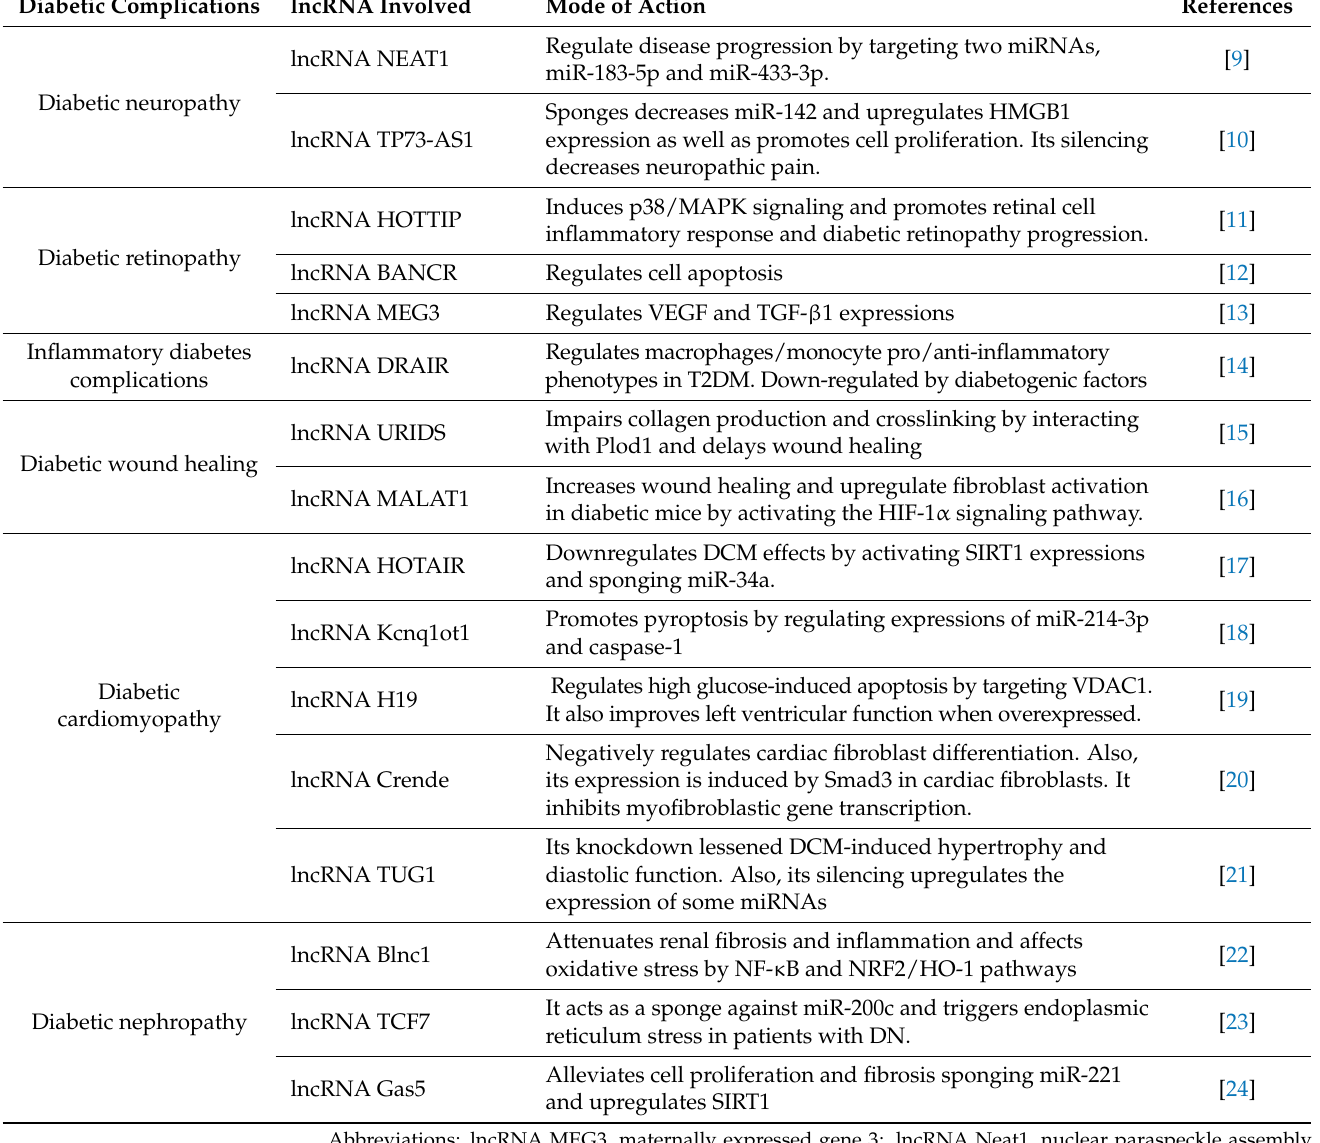
Table 1. LncRNAs involved in various diabetes-associated